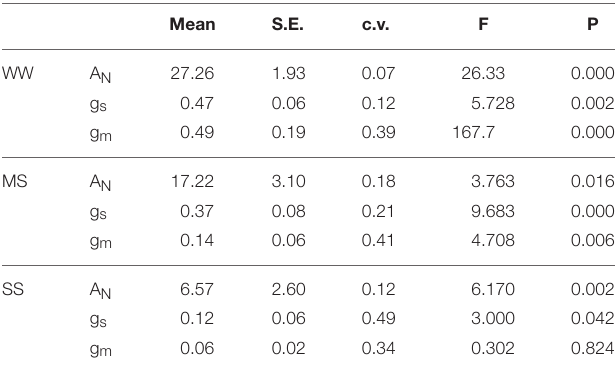
TABLE 3 | Genotypic variability of the net CO 2 assimilation rate (A N ; µ mol m − 2 s − 1 ), stomatal conductance to H 2 O (g s ; mol H 2 O m − 2 s − 1 ),